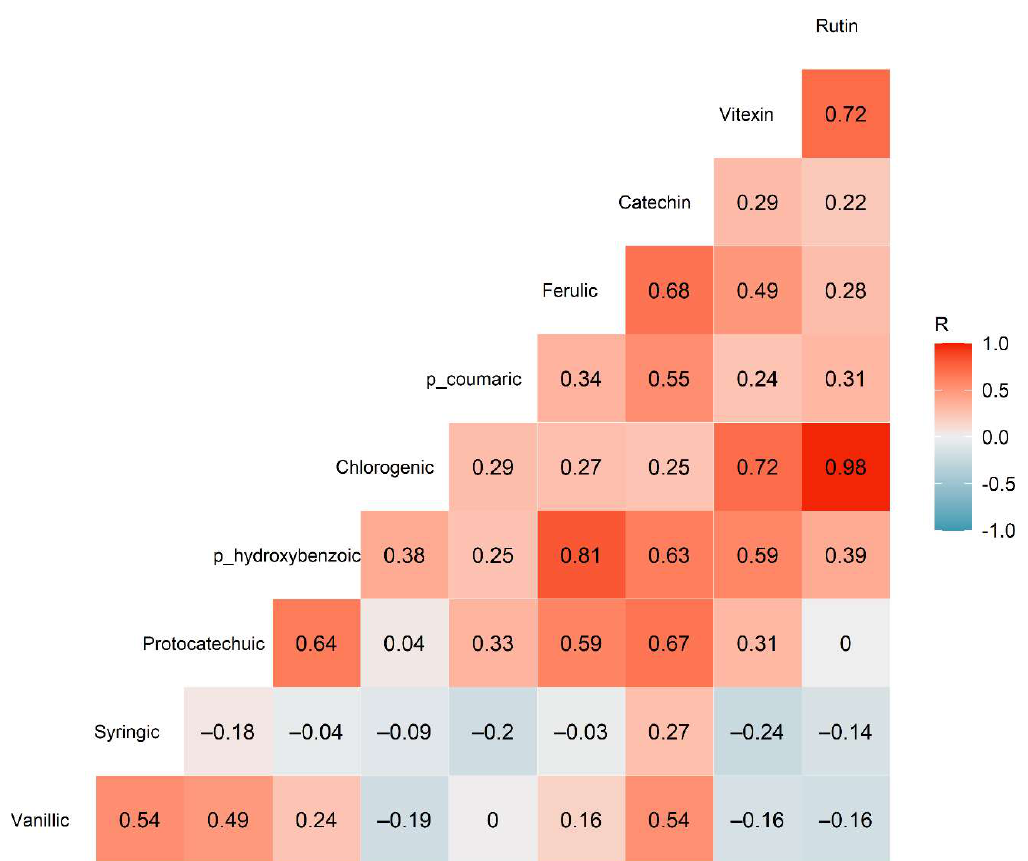
Figure 4. Correlogram showing the correlations between the various phenolic acids and flavonoids quantified in the faba bean samples ( n = 60 replicates). The numbers inside each square show the Pearson R correlation values.